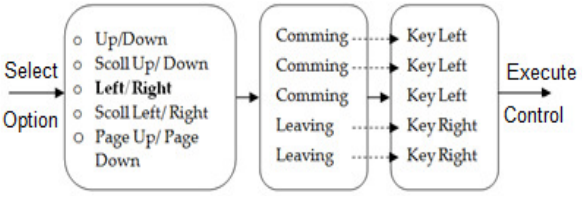
Figure 14. Selecting functional diagram of the control